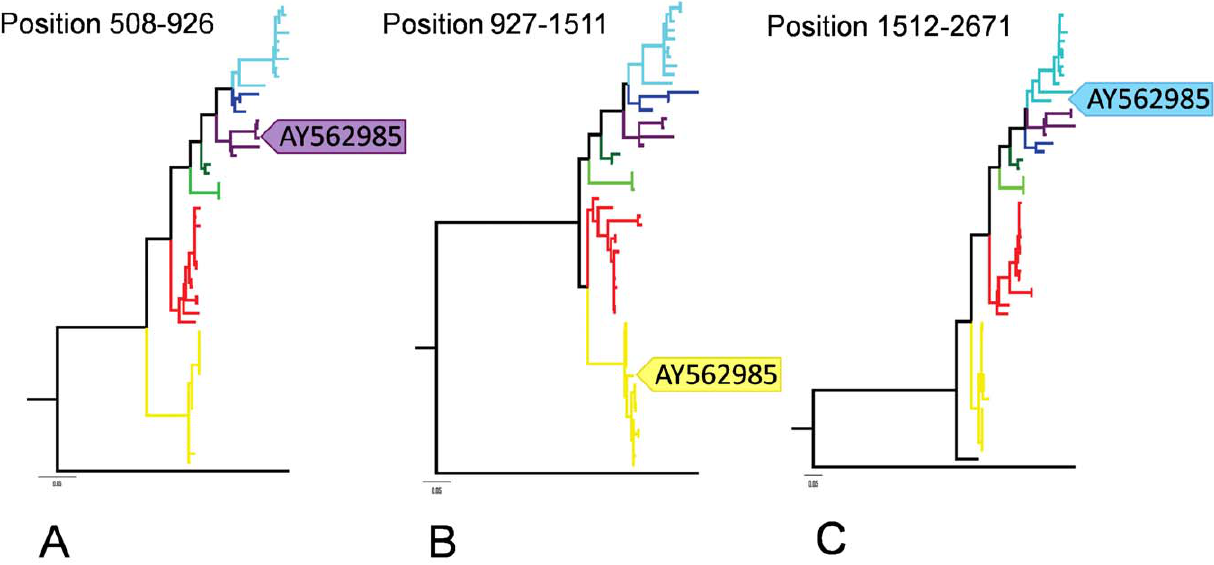
Figure 3. ML trees on the three putative recombinant regions identified in AY562985. A–C represent the phylogenies of regions spanning nucleotide position 508–926, 927–1511, and 1512–2671, respectively. The position of AY562985 is highlighted in each tree. Genotypes I, II, III, V, VI, and VII are coded using the color scheme described in Figure 1. Trees are rooted with strain DQ097393, which belongs to class I aPMV-1.